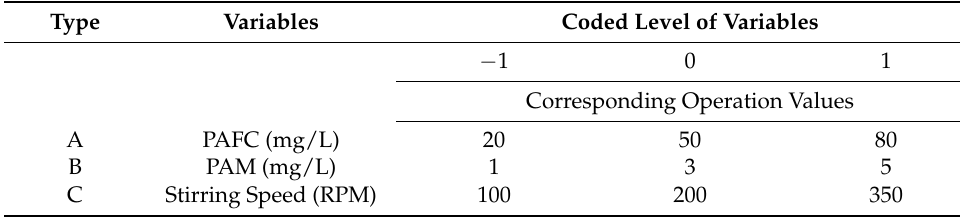
Table 1. Type, parameters and corresponding coded levels for RSM.